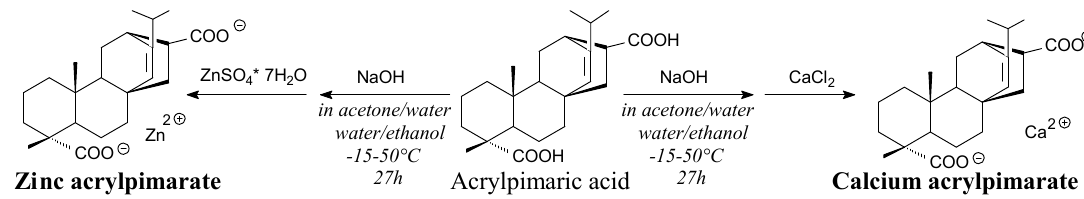
Scheme 36. Synthesis of acrylpimaric acid divalent metal salts.